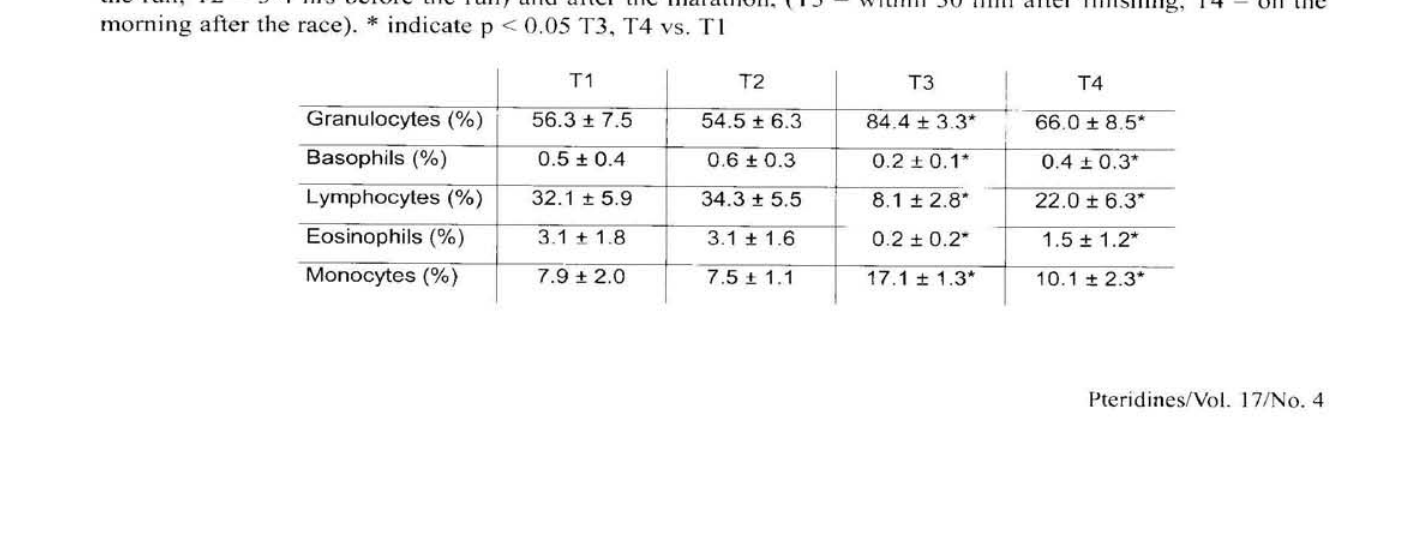
Table 2: White blood cell count before and after the marathon. Blood was collected before (T1 - 3-4 days before the run; T2 = 3-4 hrs before the run) and after the marathon, (T3 = within 30 min after finishing; T4 = on the morning after the race). * indicate ρ < 0.05 T3, T4 vs.